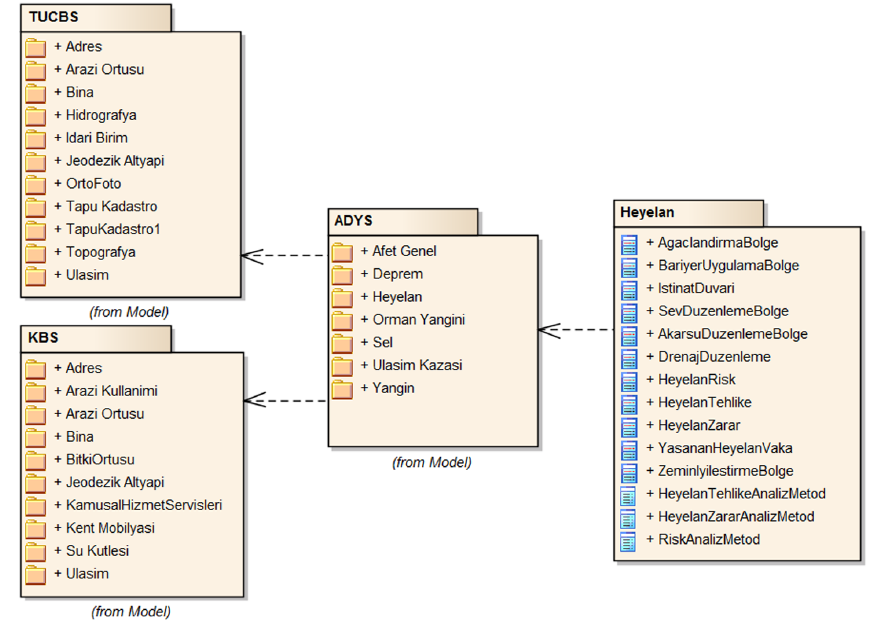
Figure 2. Data themes in TUCBS, KBS and ADYS data models and feature types in the landslide theme.